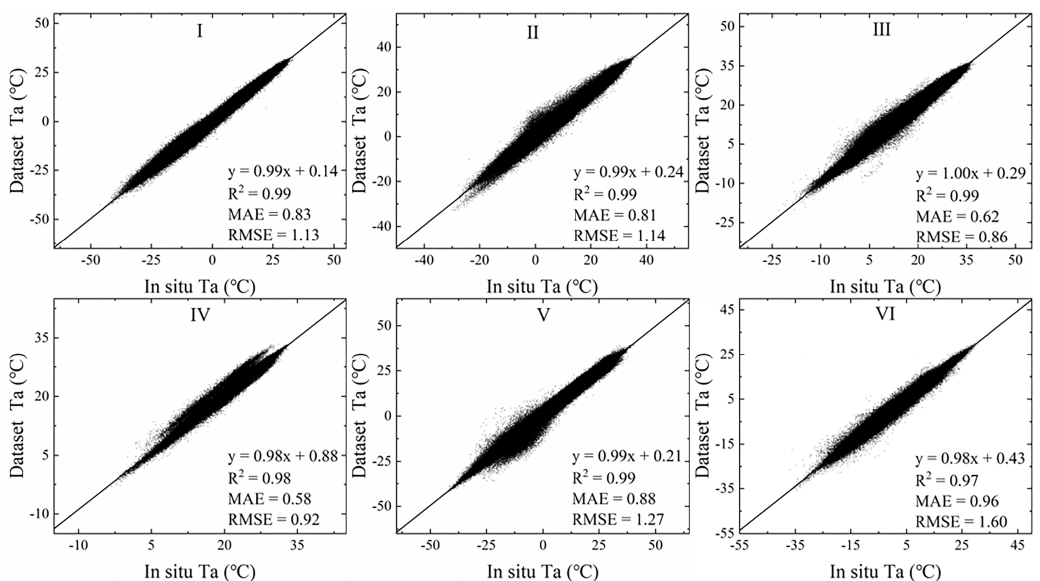
Figure 8. Scatter diagrams of the T avg output from the T a model against ground station data; statistical accuracy measures ( R 2 , MAE, and RMSE) are also indicated.